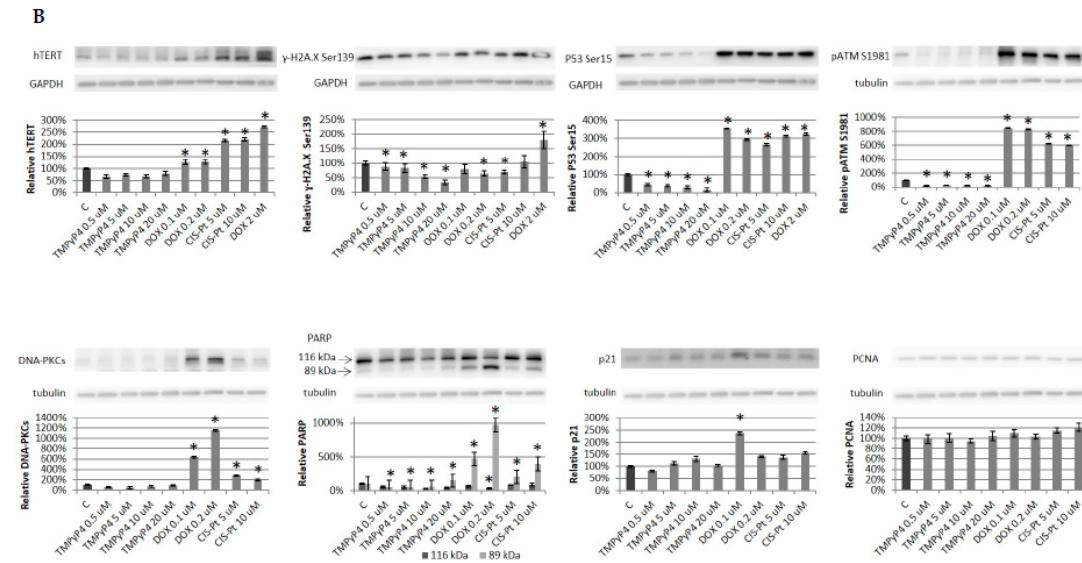
Figure 6. TMPyP4 does not induce DNA damage / repair-associated pathways. The influence of TMPyP4 (0.5, 5, 10 or 20 µ M) on individual proteins was assessed in both MCF7 ( A ) and MDA-MB-231 cells ( B ). Cells were treated for 72 h, followed by lysis and immunodetection. Typical result out of 3 replicates was demonstrated. In experiments that were assessing proteins with a low basal level, the additional positive control was included (2 µ M DOX, 2 h treatment). Densitometry analysis was performed out of 3 scanned membranes from 3 independent experiments, relative to the loading control, GAPDH (hTERT, γ -H2A.X, P53) or tubulin (pATM, DNA-PKCs, PARP, p21, PCNA). * p < 0.05, relative to control sample.